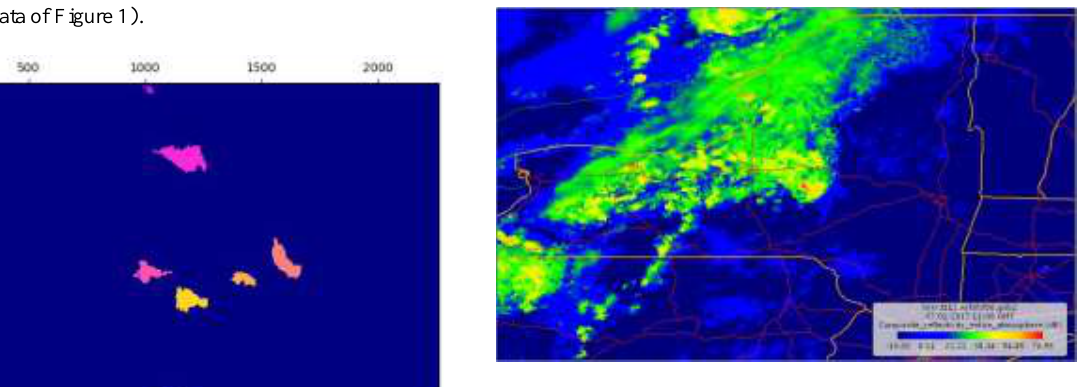
Figure 11. Composite reflectivity. 11Z July 1, 2017 showing severe weather affecting Central New